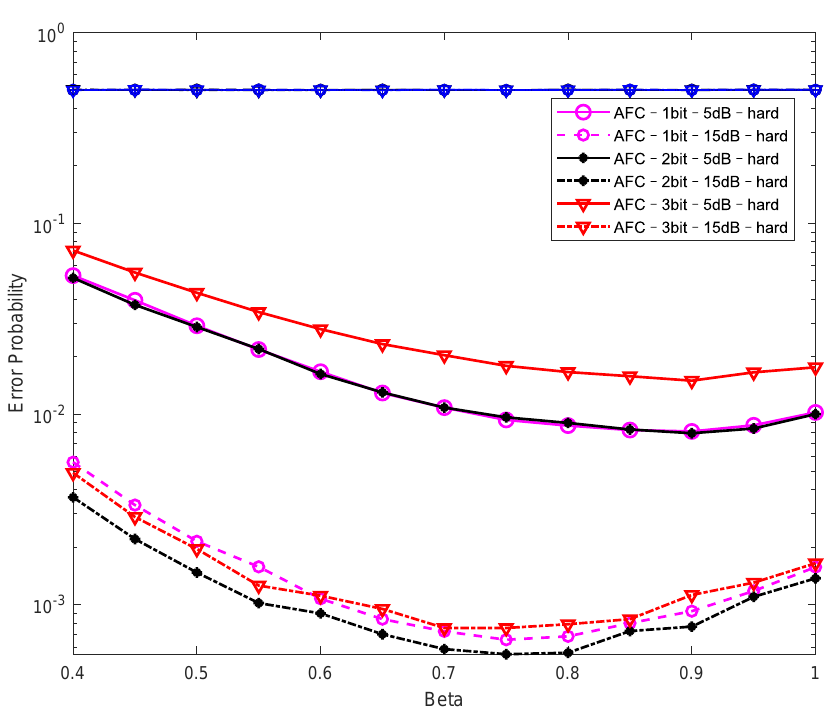
Figure 8. Error probabilities of the hard data fusion varying with β for SNR = 5, 15 dB and snr L = 5 dB.